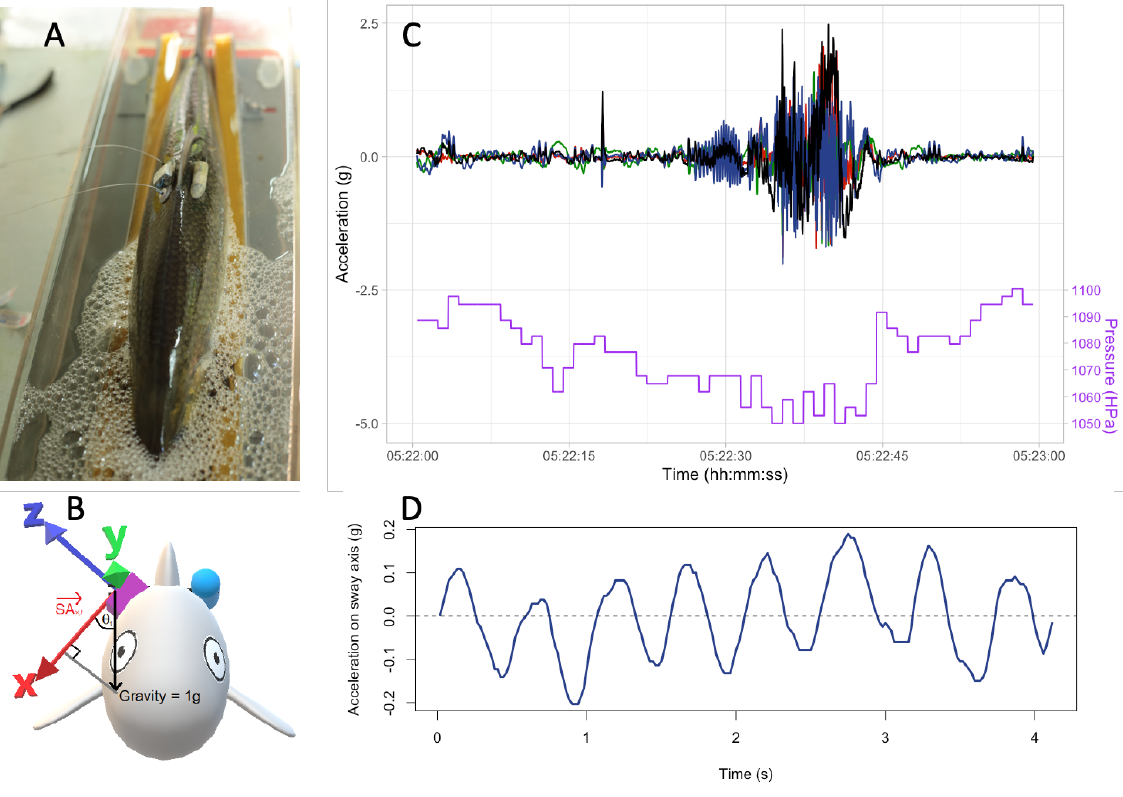
Figure 1. A. Allis shad were tagged under anaesthesia with a radio transmitter on the left flank and an accelerometer on the right flank. The accelerometer continuously recorded acceleration on three axes. B. """""""""⃗ , corresponds to the The static component of acceleration recorded on the x-axis at time t , 𝑆𝐴 ,,# orthogonal projection of gravity, which is vertical by definition, on this axis. Hence, the angle q between """""""""⃗) . C. The dynamic = 𝑐𝑜𝑠 *+ (𝑆𝐴 the x-axis and the vertical plane can be computed for any time t as 𝜃 # ,,# component of acceleration (here smoothed with a 31-point wide median filter) can be used to detect spawning acts, characterized by increased acceleration on both x (red), y (green) and y (blue) axes, resulting in a peak in the norm of the 3-dimensional acceleration vector (black), and accompanied by a decrease in hydrostatic pressure (purple). D. After correction for the q angle, the z-axis corresponds to the sway axis of the fish, and its dynamic component (here smoothed with a 5-point wide median filter) can be used to compute tail beat frequency (TBF) as the number of zero-crossings per unit of